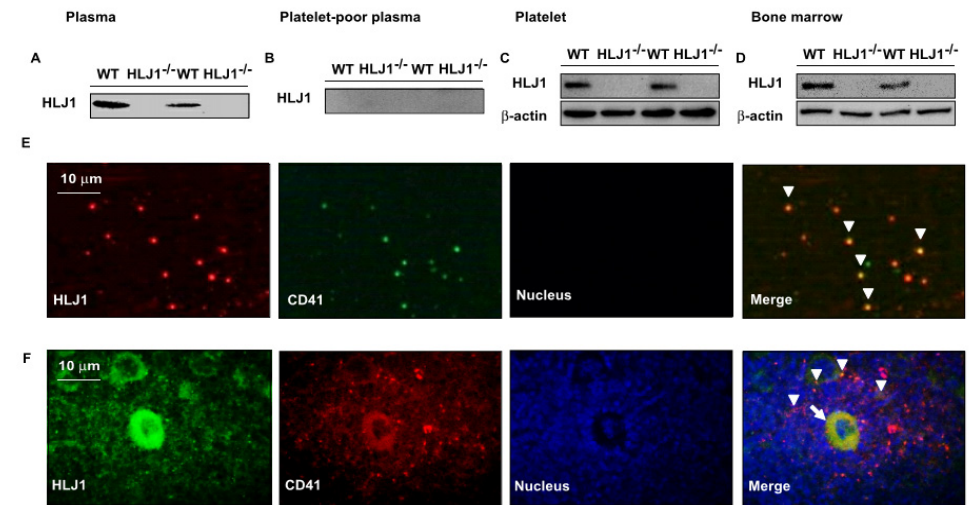
Figure 1. Expression of HLJ in plasma and bone marrow of WT and HLJ1 -/- mice. ( A – D ) Western blot analysis of HLJ1 in plasma, platelet-poor plasma, platelets and bone marrow. ( E ) Representative images of HLJ1 expression in platelets (arrowheads) of plasma by immunohistochemistry staining. ( F ) Representative images of HLJ1 expression in platelets (arrowheads) and megakaryocytes (arrow) of bone marrow by immunohistochemistry